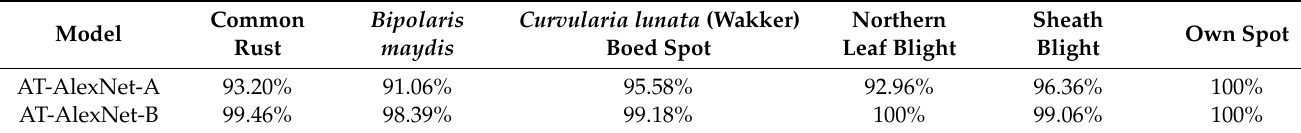
Table 4. Model recognition accuracy before and after data